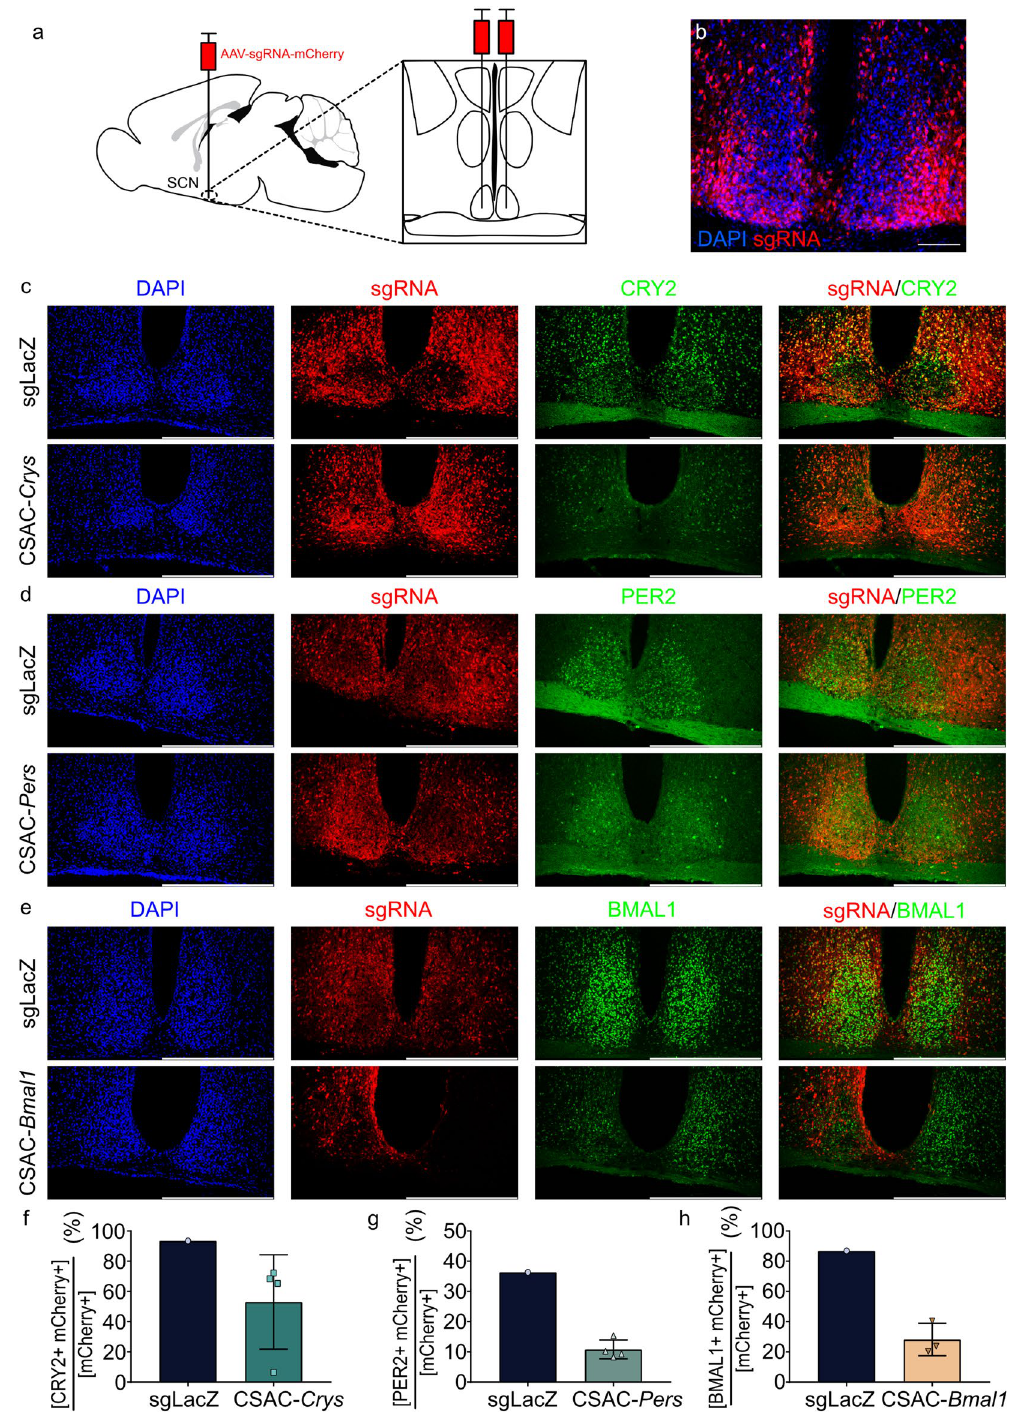
Figure 4. SCN injection with CSAC. ( a ) Schematic representation of stereotaxic CSAC injection into the SCN. AAVs expressing sgRNAs targeting core clock components and the mCherry fluorescent marker were bilaterally injected into the SCN of Cas9-expressing mice. ( b ) Representative confocal microscopic image of the brain section containing CSAC- injected SCN. sgRNA-expressing cells are co-labeled with mCherry as a surrogate marker. Scale bar = 100 μm. ( c – e ) Immunohistochemical analysis of brain sections containing the SCN of mice injected with CSAC- Crys ( c ), CSAC- Pers ( d ), and CSAC- Bmal1 ( e ). Scale bar: 100 μm for ( b ) and 500 μm for ( c – e ). ( f – h ) Co-expression ratio of targeted clock proteins and CSAC. Percentage of clock protein-positive and mCherry-positive cells over mCherry-positive cells were quantified. ( f ) Co-expression percentages of CRY2 and mCherry are indicated for the sgLacZ or CSAC- Crys group. ( g ) Co-expression percentages of PER2 and mCherry are indicated for the sgLacZ or CSAC- Pers group. ( h ) Co-expression percentages of BMAL1 and mCherry are indicated for the sgLacZ or CSAC- Bmal1 group. Error bar = standard deviation (n = 1 mouse for sgLacZ; 3–4 mice for CSAC- Crys , CSAC- Pers , and CSAC- Bmal1 ,